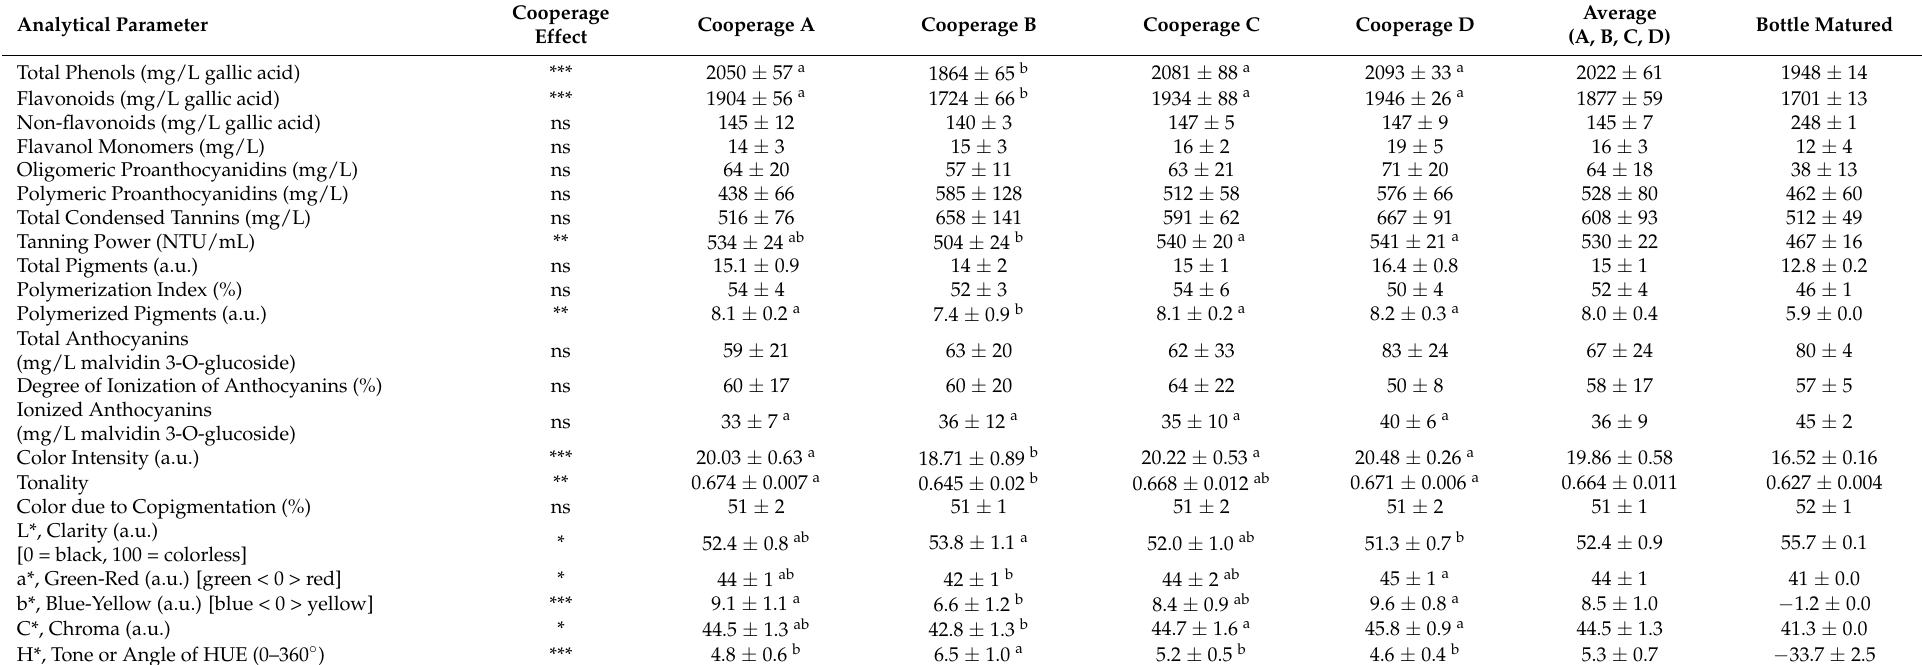
Table 2. Color, pigments, and phenolic composition of red wines after 12 months of aging in oak barrels by cooperage and of a bottle matured sample, and cooperage effect with statistical difference between the